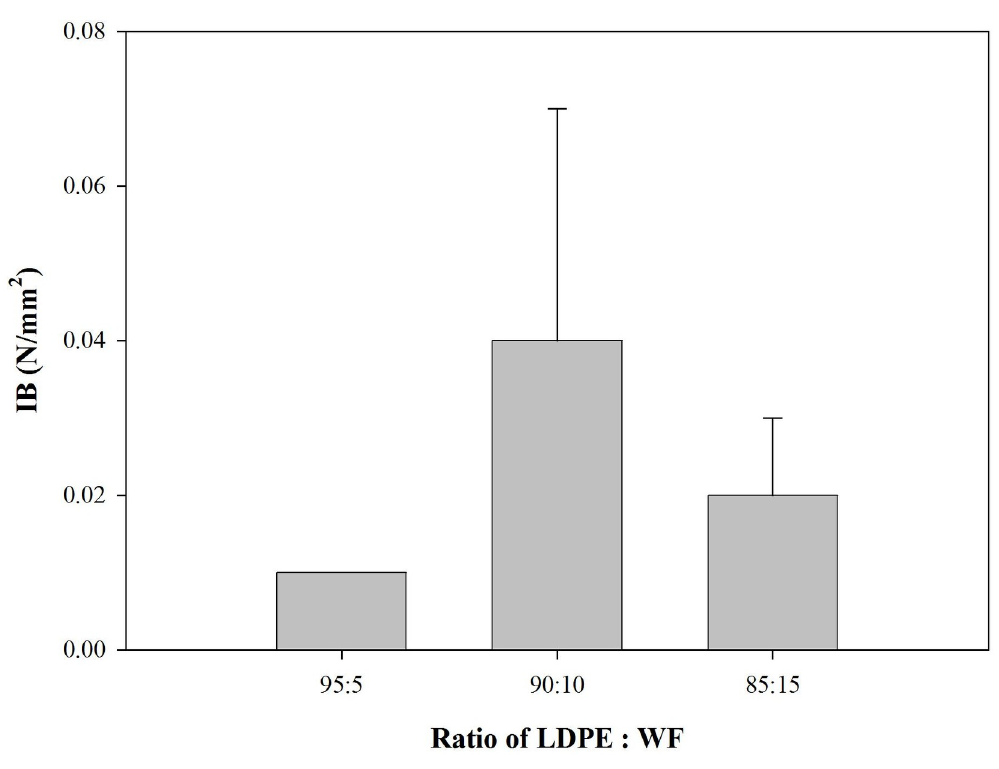
Fig 8. IB of predominantly plastic WPC.